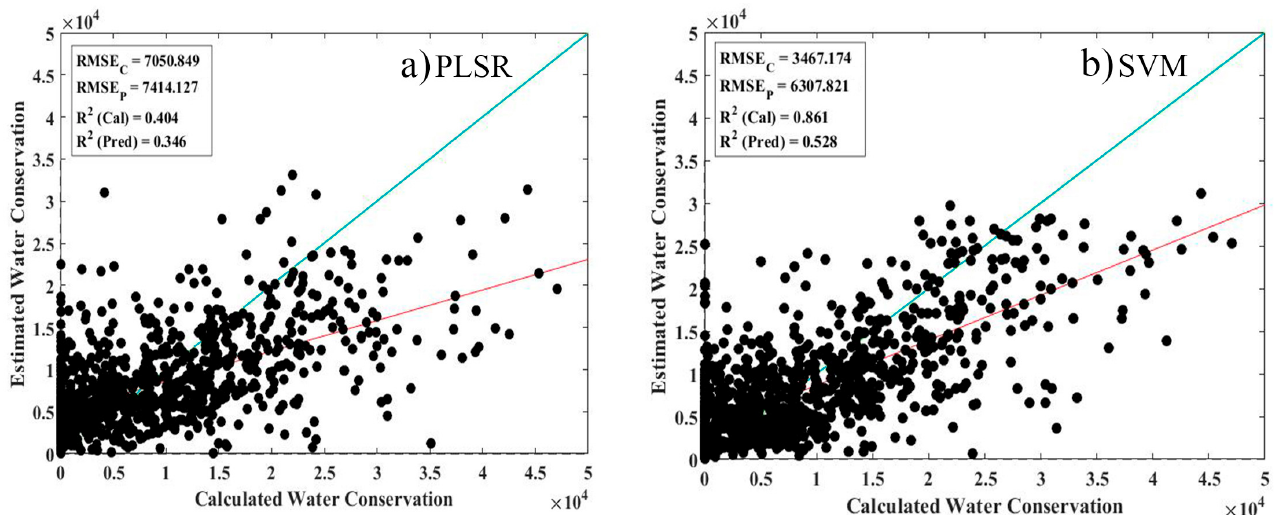
Figure 7. Scatter plots of calculated and prediction values by ( a ) partial least squares regression (PLSR) and ( b ) a support vector machine (SVM) model using all the data. Note: RMSE C , root mean square error (RMSE) of the calculated model, R 2 C , coefficient of determination for the calculated model, RMSE P , RMSE of the predicted results, and R 2 P , coefficient of determination for the predicted results. The blue and red lines are 1:1 and the fitted lines,